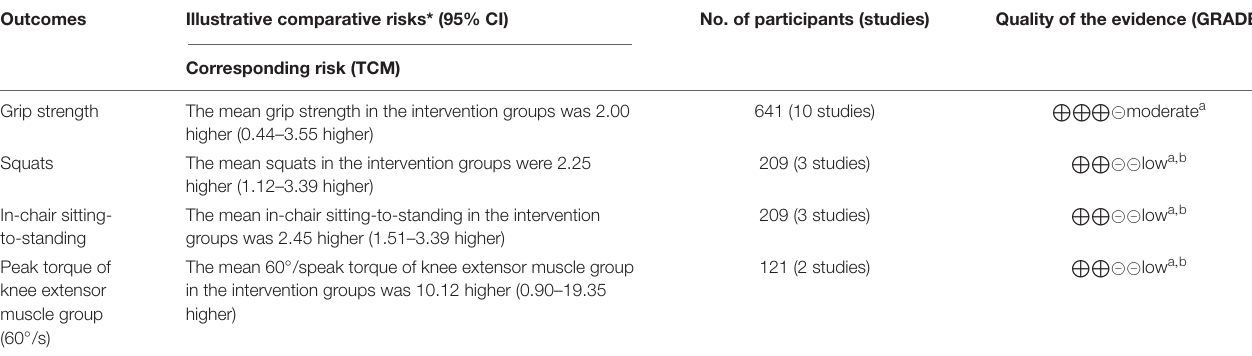
TABLE 4 | Muscle strength for